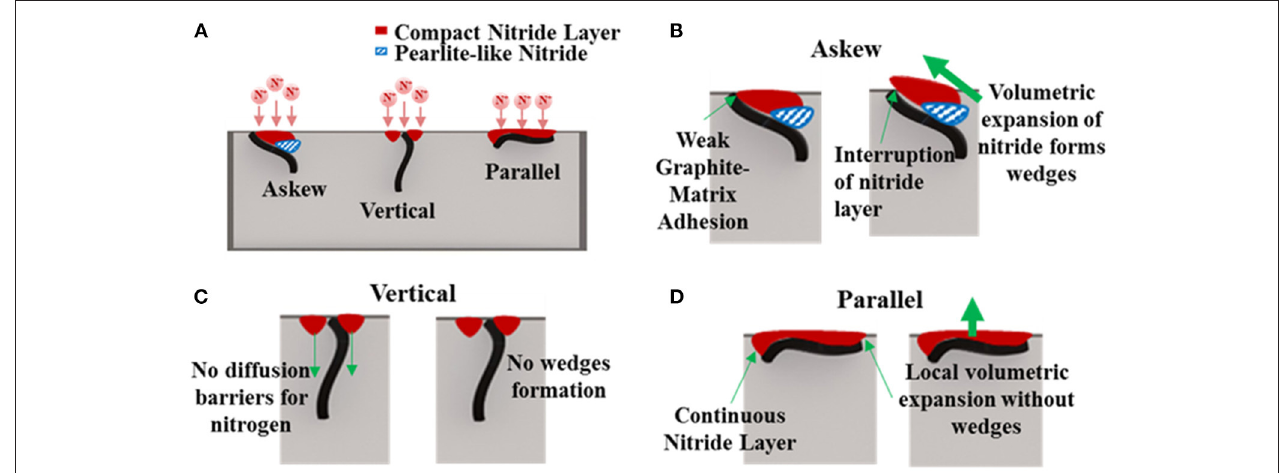
FIGURE 5 | Scheme showing different situations for the wedges formation (A) . Particular cases of graphite flakes orientation to the surface. (B) Askew, (C) vertical, and (D) parallel ( Giacomelli et al., 2017).